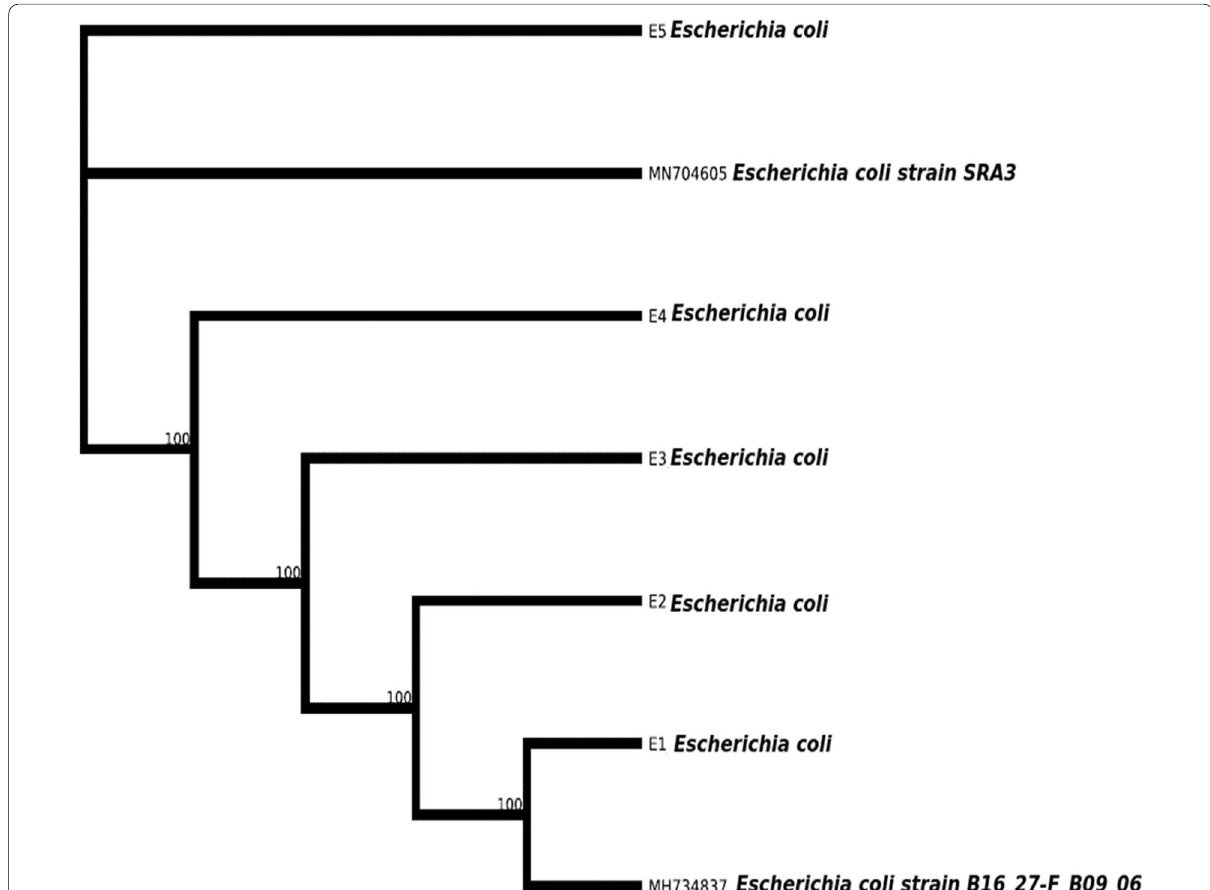
Fig. 4 Phylogenetic tree showing the genetic diversity of Escherichia coli